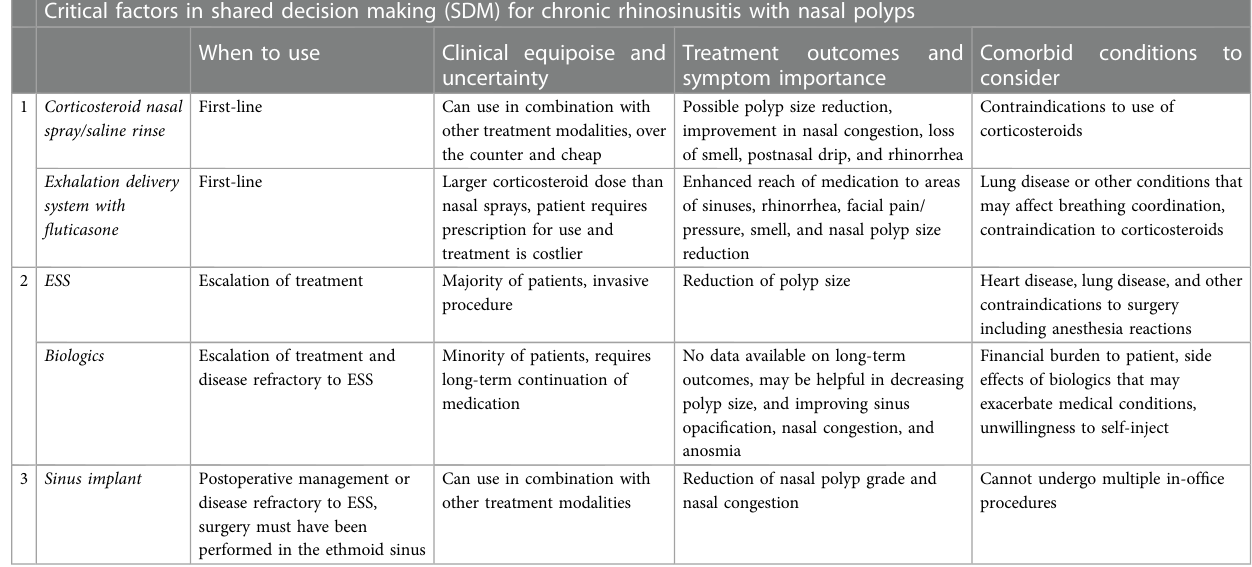
TABLE 2 Critical factors of consideration for various treatment options available for chronic rhinosinusitis with nasal polyps. Critical factors in shared decision making (SDM) for chronic rhinosinusitis with nasal